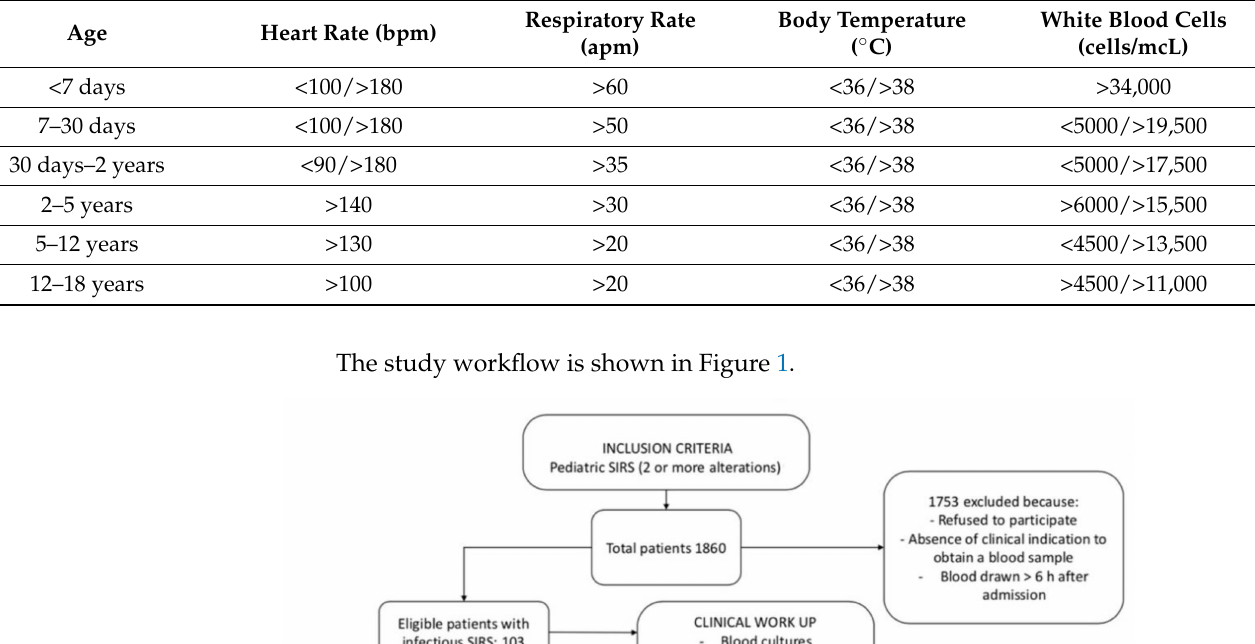
Table 1. SIRS criteria according to age (modified from reference [20]).